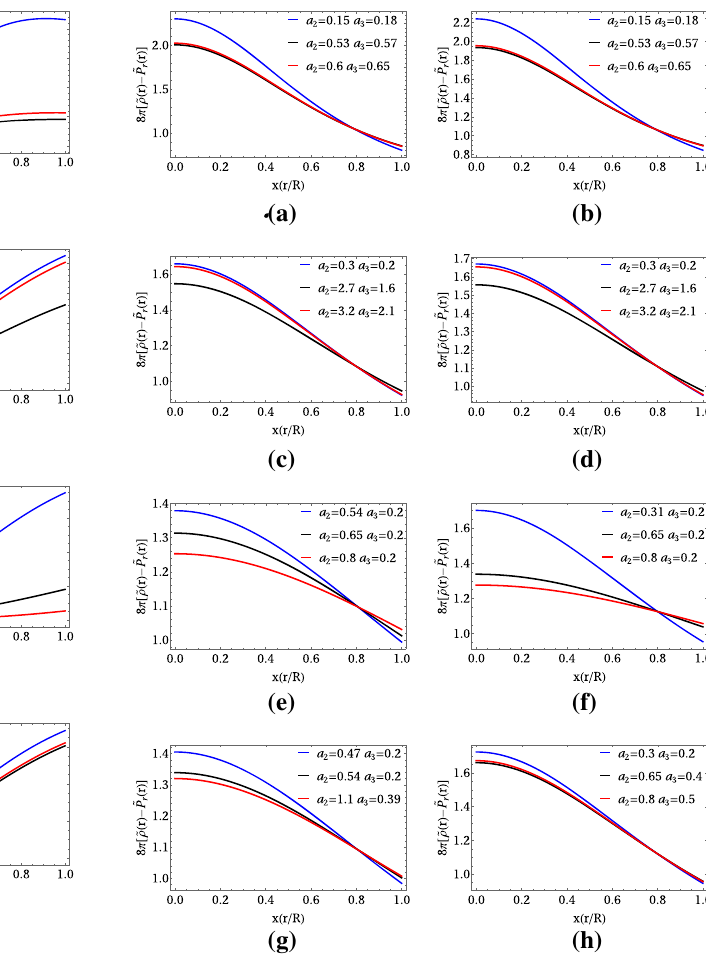
Fig. 7 ˜ ρ( r ) − ˜ P r ( r ) as a function of r for Model 1: ( a ) u = 0.19803, ( b ) u = 0.2035, Model 2: ( c ) u = 0.19803, ( d ) u = 0.2035, Model 3: ( e ) u = 0.19803, ( f ) u = 0.2035, Model 4: ( g ) u = 0.19803, ( h ) u =